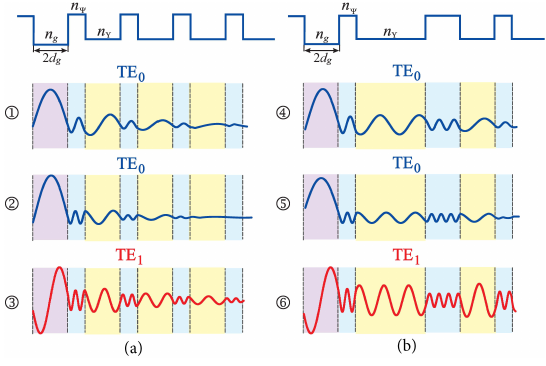
Figure 3: Electric-field patterns related to the E x component of the field for TE m modes. The refractive index profile of the correspond- ing waveguide is presented on the top of figure. The confinement factor is: (1) Γ = 0.77 ; (2) Γ = 0.92 ; (3) Γ = 0.22 ; (4) Γ = 0.73 ; (5) Γ = 0.87 ; (6) Γ = 0.35 .